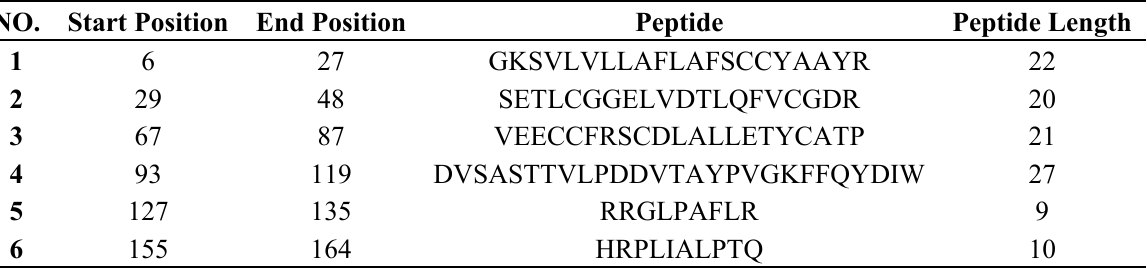
Table 4. The antigenic amino acid sequences and its